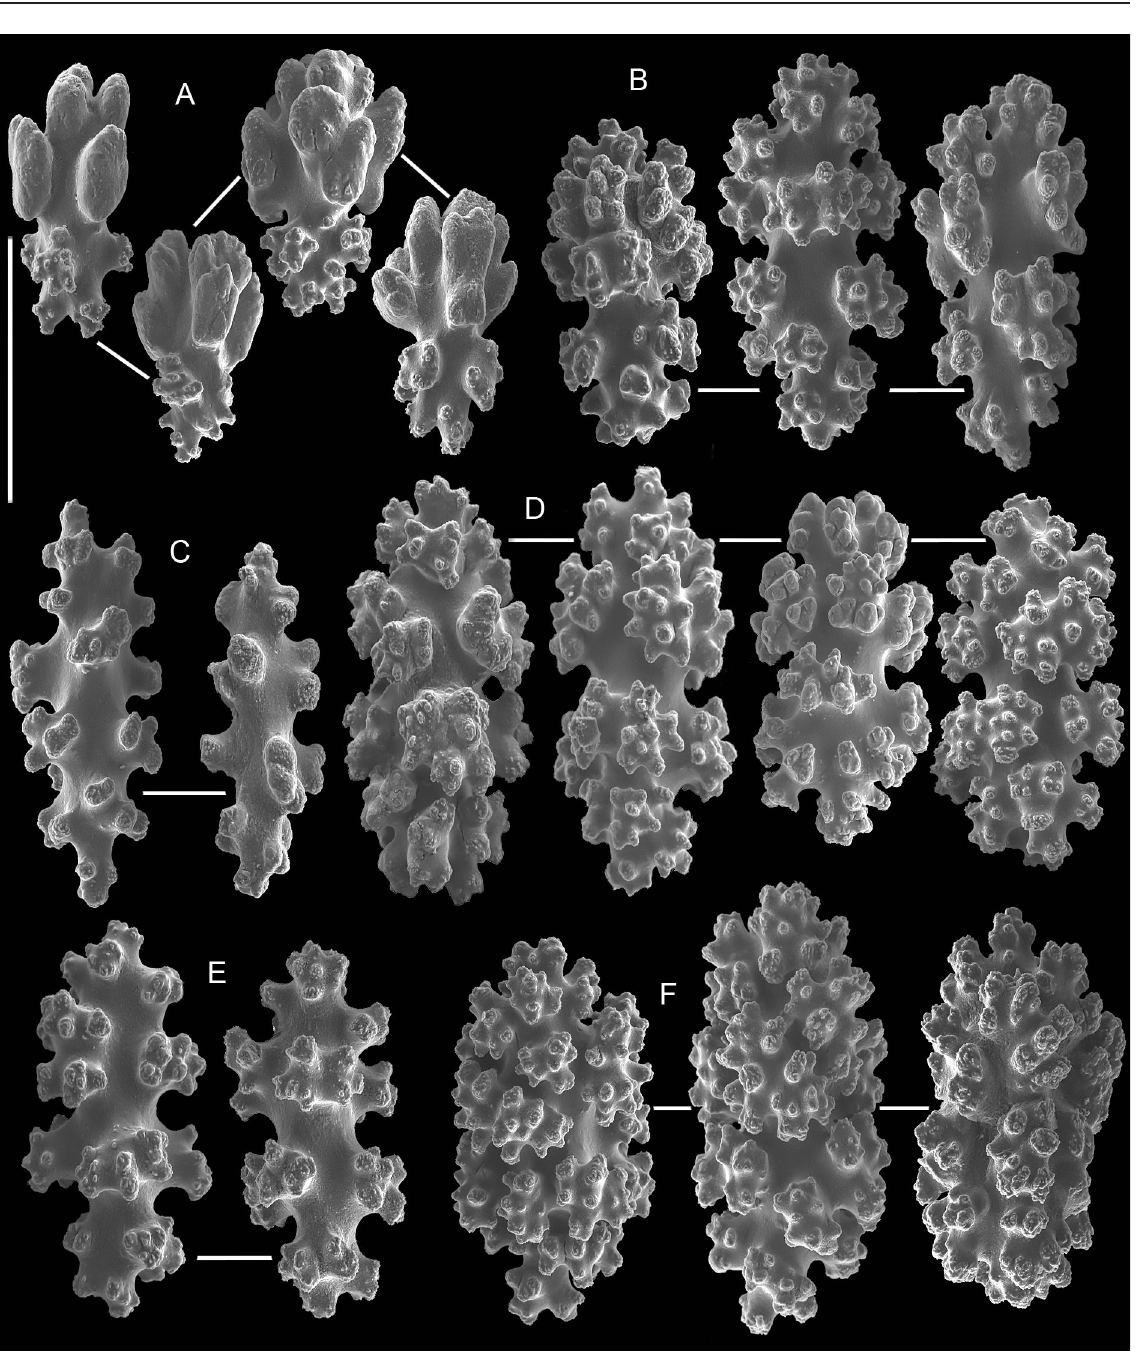
Fig. 4. Calcigorgia matua sp. nov., holotype (MIMB 20722), sclerites from the coenenchyme. A . Clubs with a head consisting of leafy processes. B . Warty clubs. C . Spindles. D . Well calcified capstans. E . Capstans with less developed processes. F . Ovals. Scale bar: 0.1